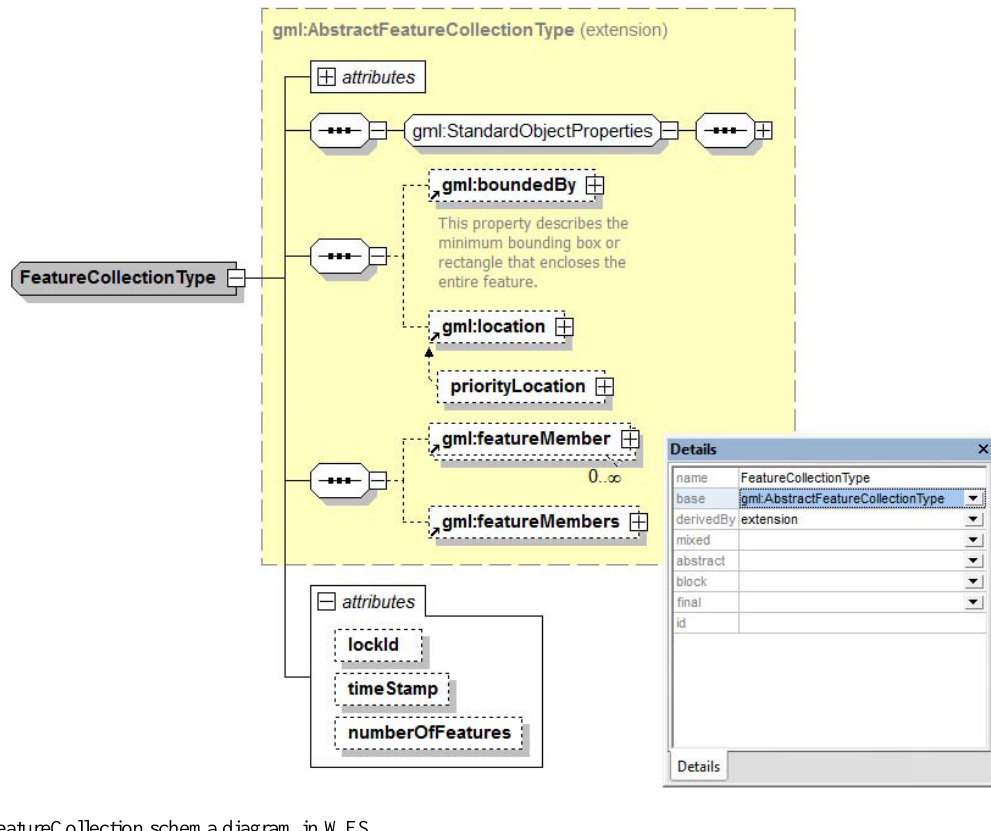
Fig. 9. The FeatureCollection schema diagram in WFS.